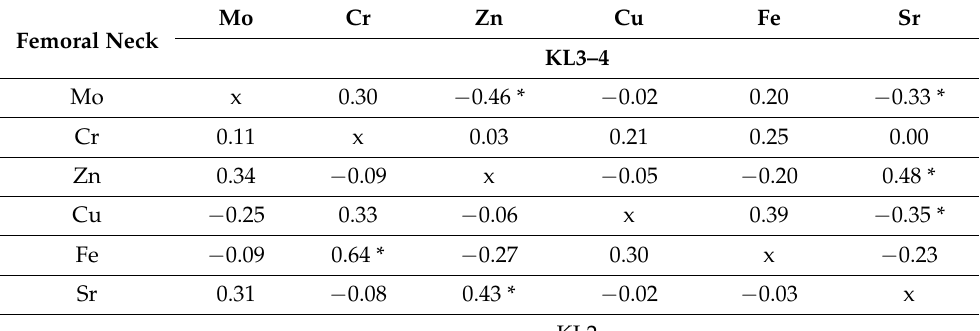
Table 4. Spearman’s correlation coefficients for the metals found in the femoral neck for mild and severe grades of OA.